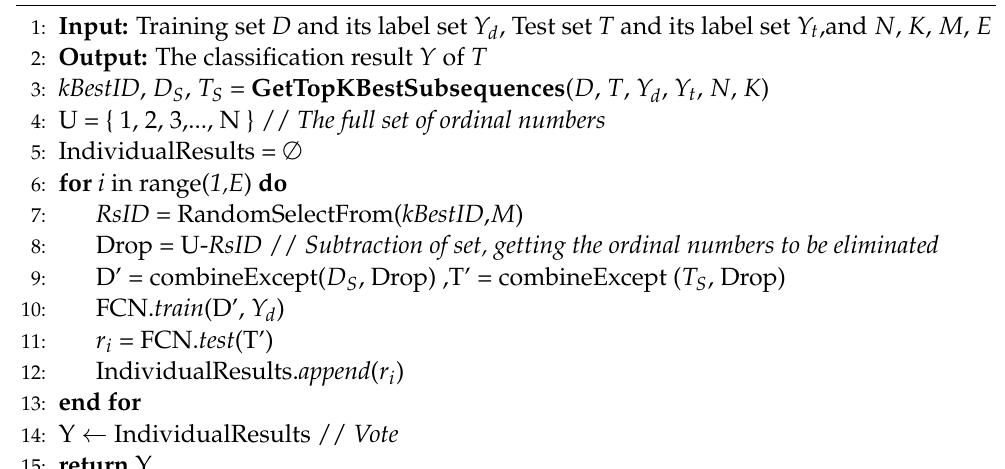
Algorithm 2 Random Subspace Ensembles of